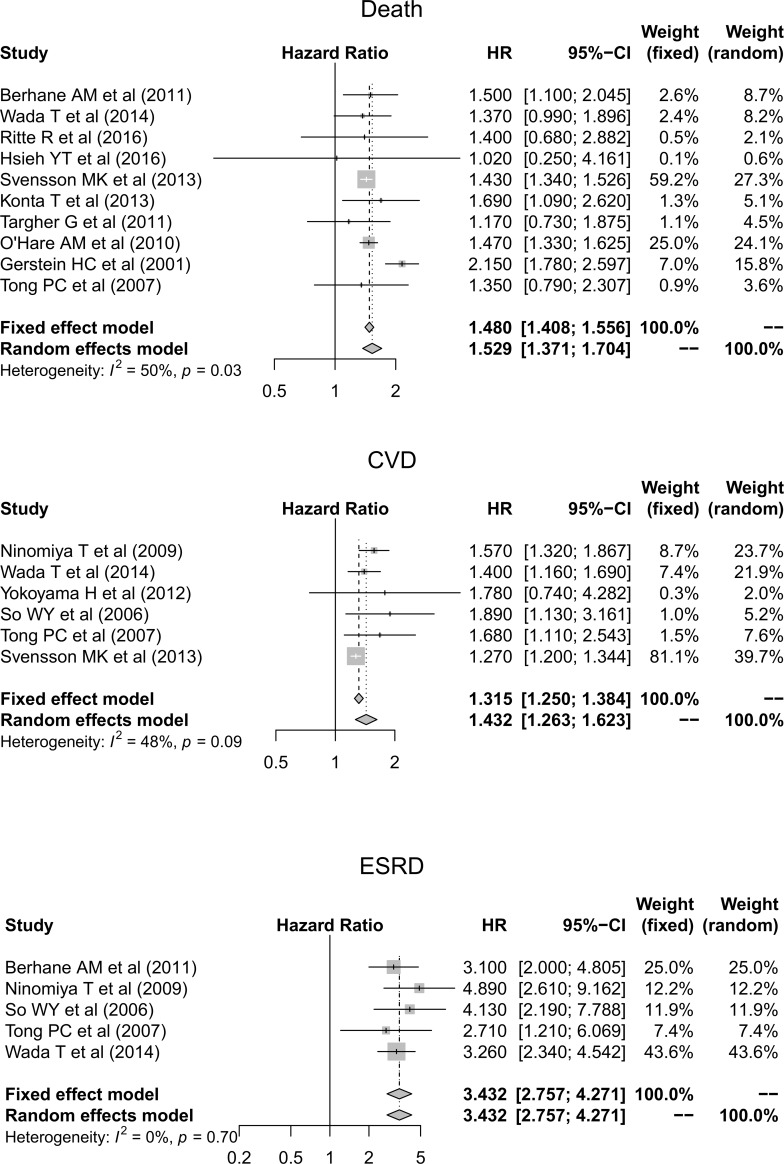
Relative hazard ratios for major clinical outcomes such as death, cardiovascular disease, and end-stage renal disease in diabetic patients with albuminuria and eGFR ≥60 ml/min/1.73 m2 compared to normo-albuminuric diabetic patients.Abbreviations: CVD, cardiovascular disease; CI, confidence interval; ESRD, end-stage renal disease; HR, hazard ratio.